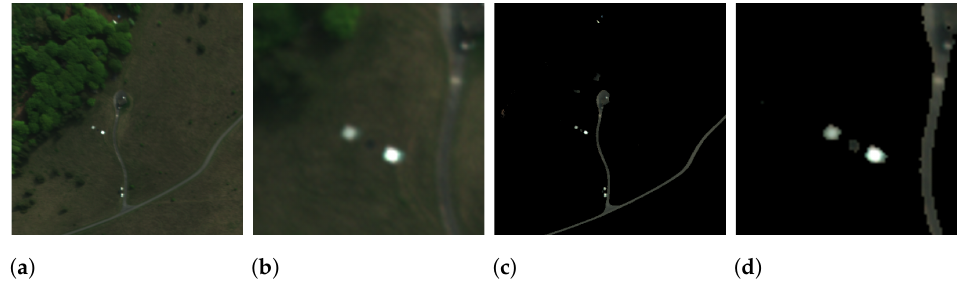
Figure 9. Example of the OP7 Dataset. ( a ) False colour image of the target area. ( b ) Enlarged version of ( a ). ( c ) Retained pixels following the NDVI re spatial masking. ( d ) Enlarged version of ( c